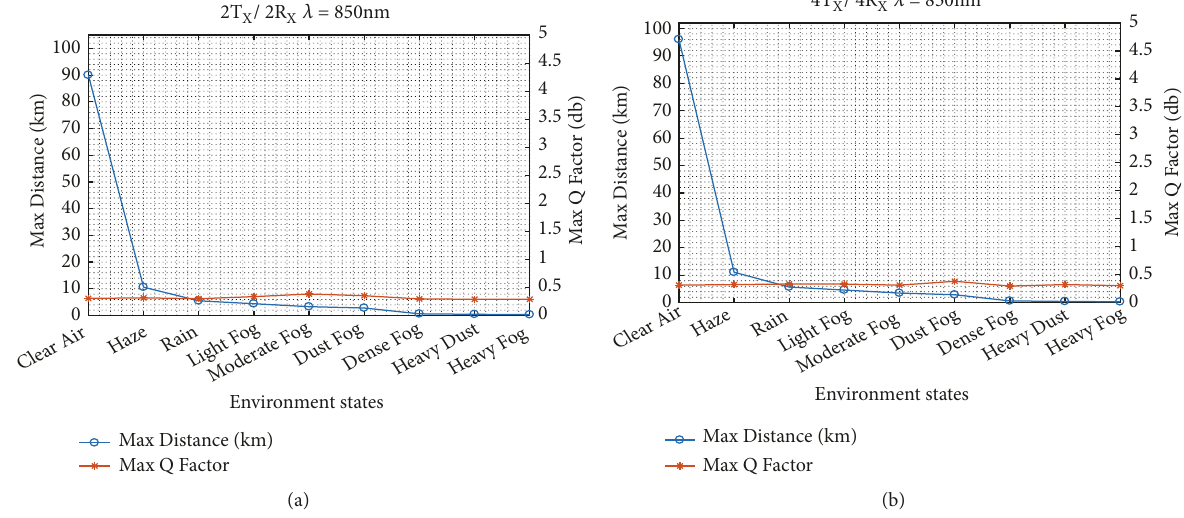
Figure 5: Relation between max distance (km) and attenuation (db/km) at wavelength=850nm. (a) Using 2T X /2R X ; (b) using 4T X /4R X .